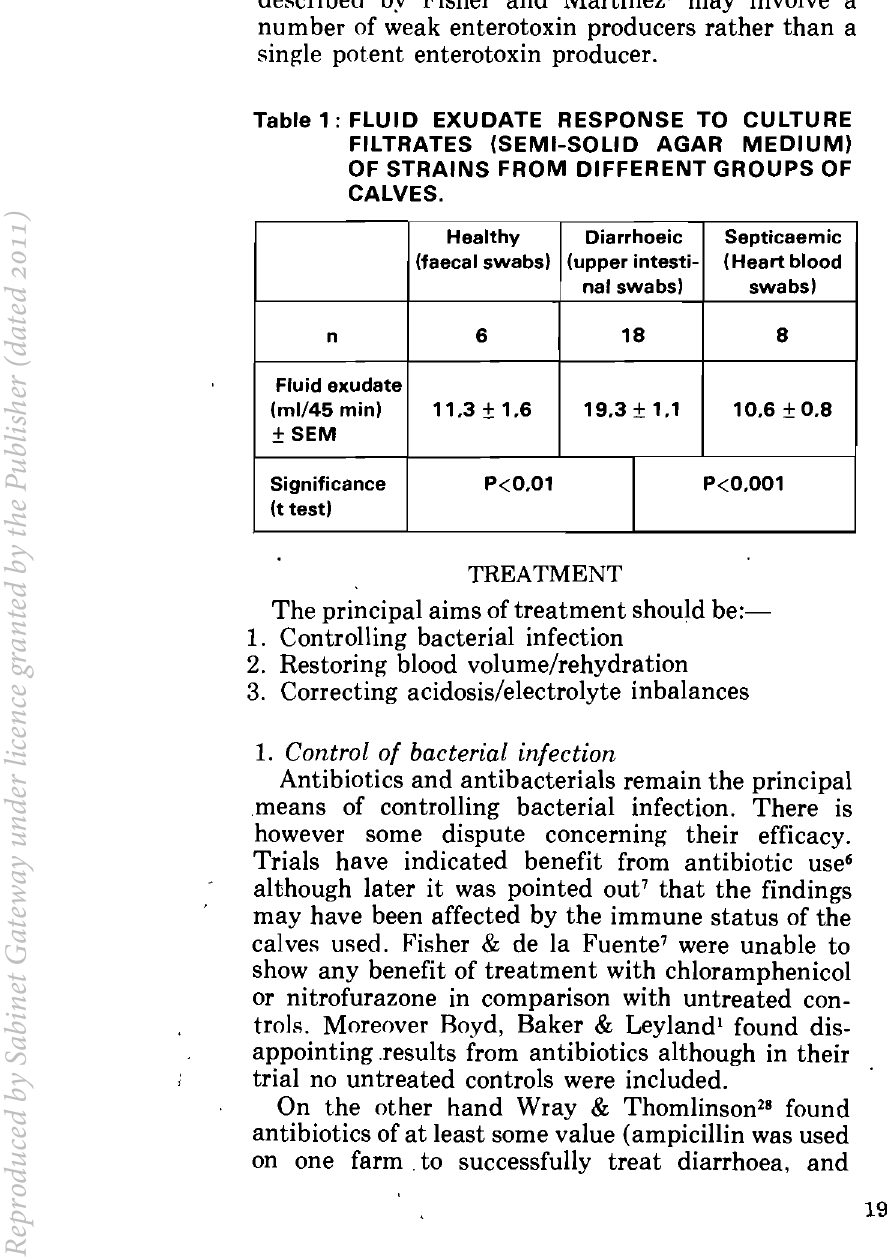
Table 1: FLUID EXUDATE RESPONSE TO CULTURE FILTRATES (SEMI-SOLID AGAR MEDIUM) OF STRAINS FROM DIFFERENT GROUPS OF CALVES.